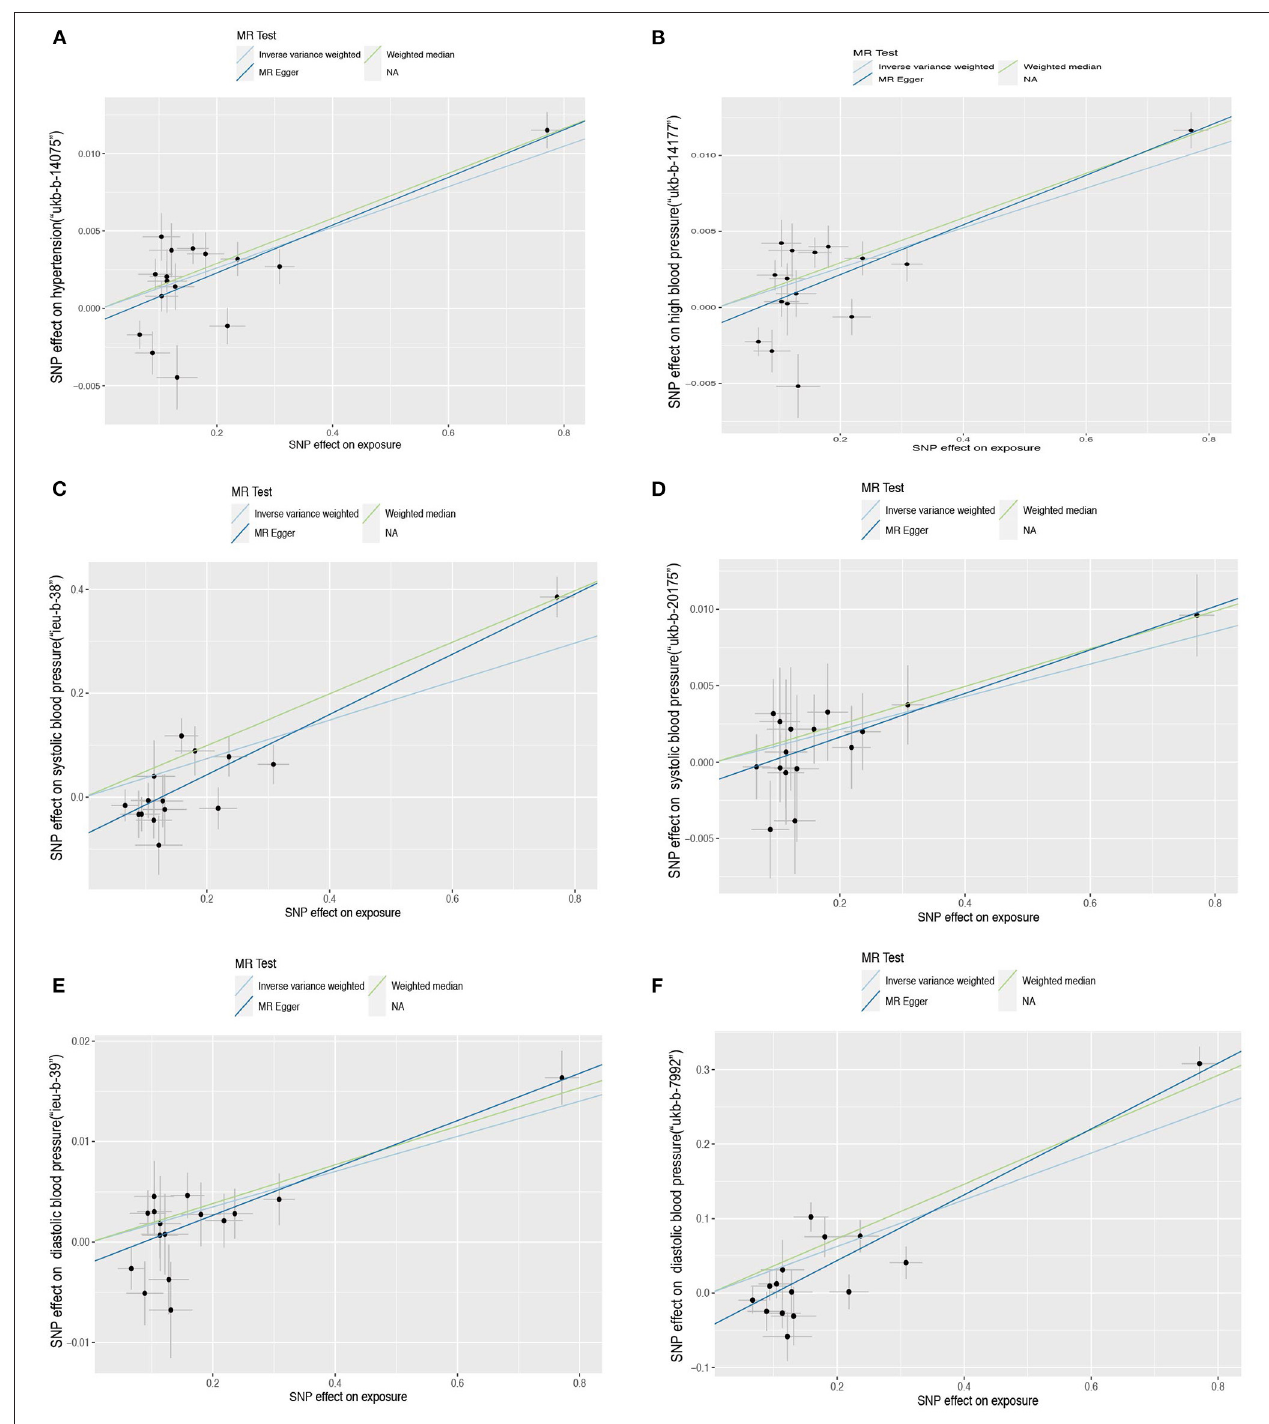
FIGURE 3 | Scatter plot of the Mendelian randomization (MR) outcome. Relationship between the effect size estimates on sUMOD (x-axis) and the effect size estimates on outcomes (y-axis): Hypertension (A,B) , systolic blood pressure (C,D) , diastolic blood pressure (E,F) . The slope of fitted lines represents the estimated causal effect of sUMOD obtained using the inverse variance weighted (IVW), MR-Egger, and weighted median (WM). Hypertension: (A) (ukb-b-14177), (B) (ukb-b-14-57); systolic blood pressure: (C) (ieu-b-38), (D) (ukb-b-20175); diastolic blood pressure: (E) (ieu-b-39), (F) (ukb-b-7992).